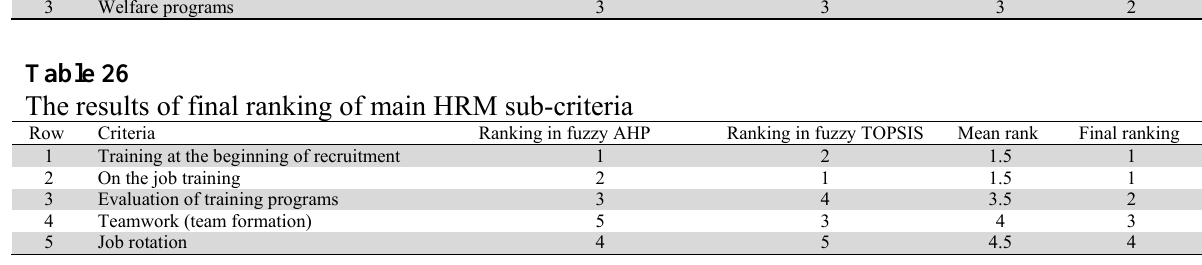
The results of final ranking of employees' health and hygiene sub-criteria Row Criteria Ranking in fuzzy AHP Ranking in fuzzy TOPSIS Ergonomics